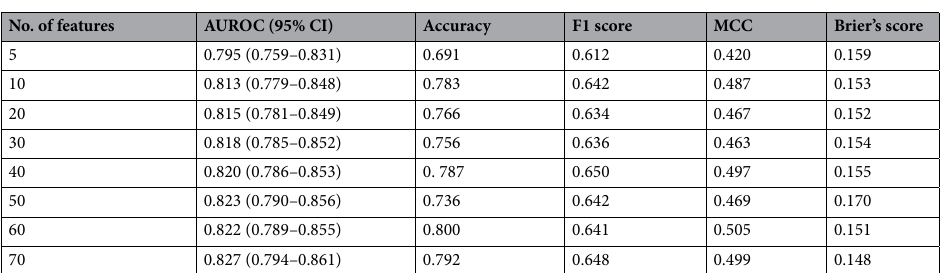
Table 3. Performance indices of extreme gradient boosting machine models in predicting hypotension (Defined as a reduction in mean arterial pressure ≥ 20 mmHg from the initial value within 6 h) according to the number of features. AUROC area under the receiver operating characteristic curve, CI confidence interval, MCC Matthews correlation coefficient.